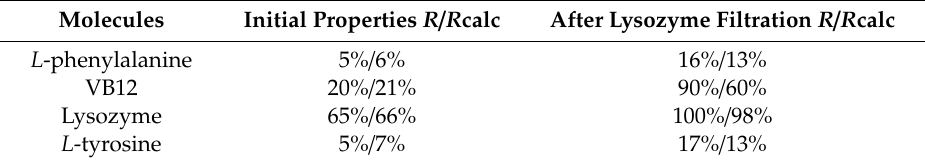
Table 5. Experimental and calculated rejection rates before and after lysozyme filtration.